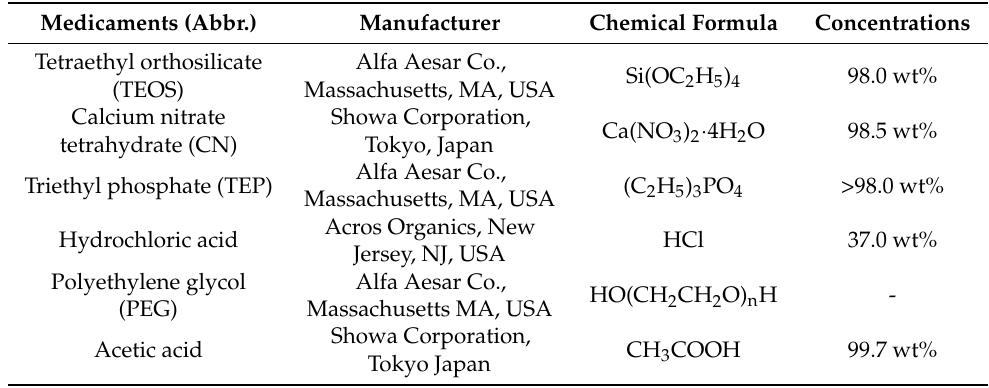
Table 1. Medicament used in the present study.